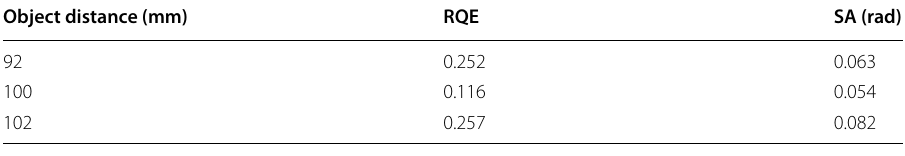
92 mm), d the spectral curves for point C ( z o = 108 mm), f the spectral curves for point E ( z o =